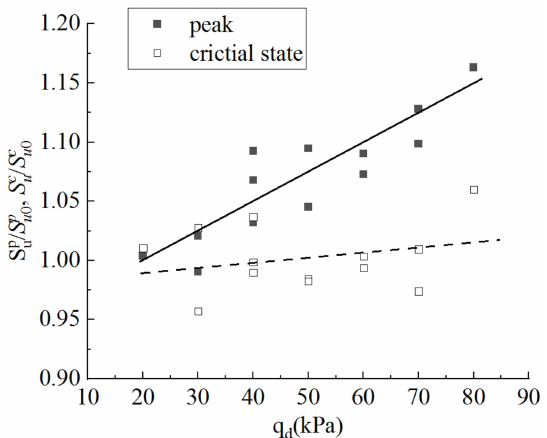
Figure 7. The relationship between normalised peak/critical state strength and cyclic stress amplitude.